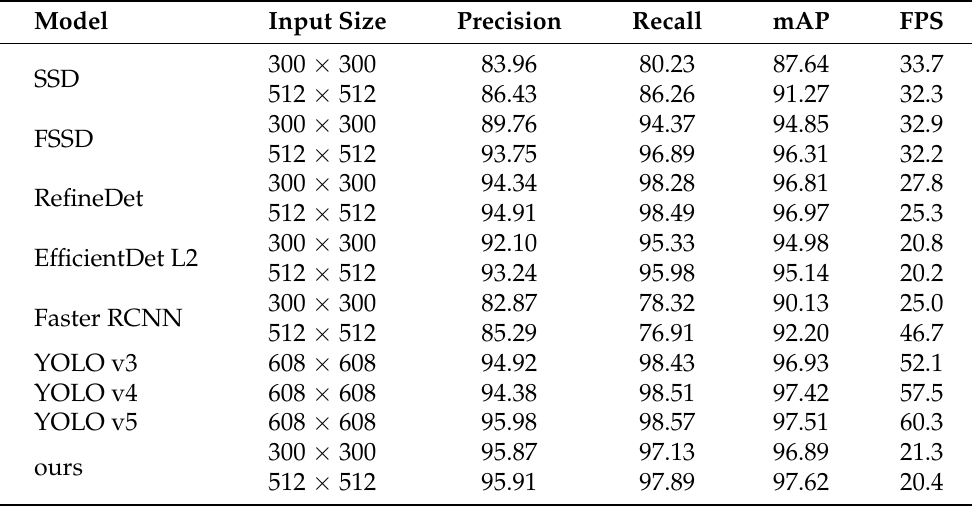
Table 8. Validation of the applicability of the model in this paper on other remote sensing datasets.